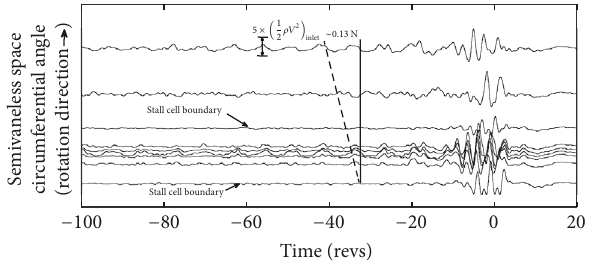
Figure 11: Unsteady pressure traces at 90% speed with 120 kg/h steam injection (Kulite transducers all located in a semivaneless space).